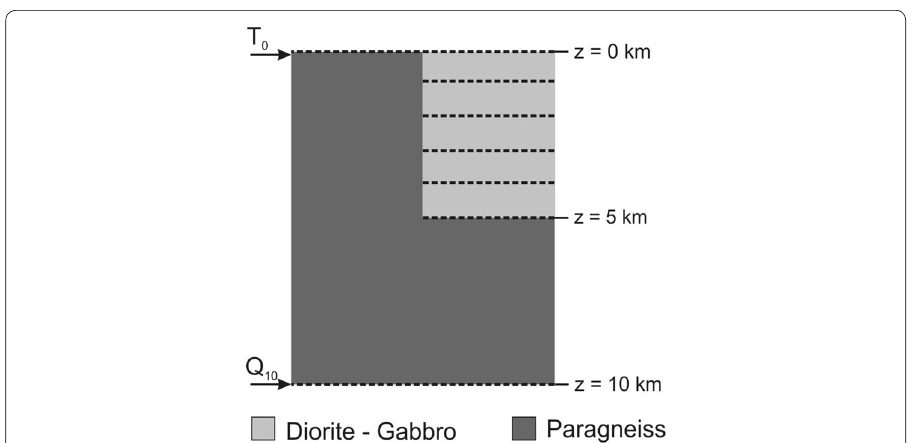
Fig. 3 Simplified geological model of the upper 10 km lithosphere stratigraphy in